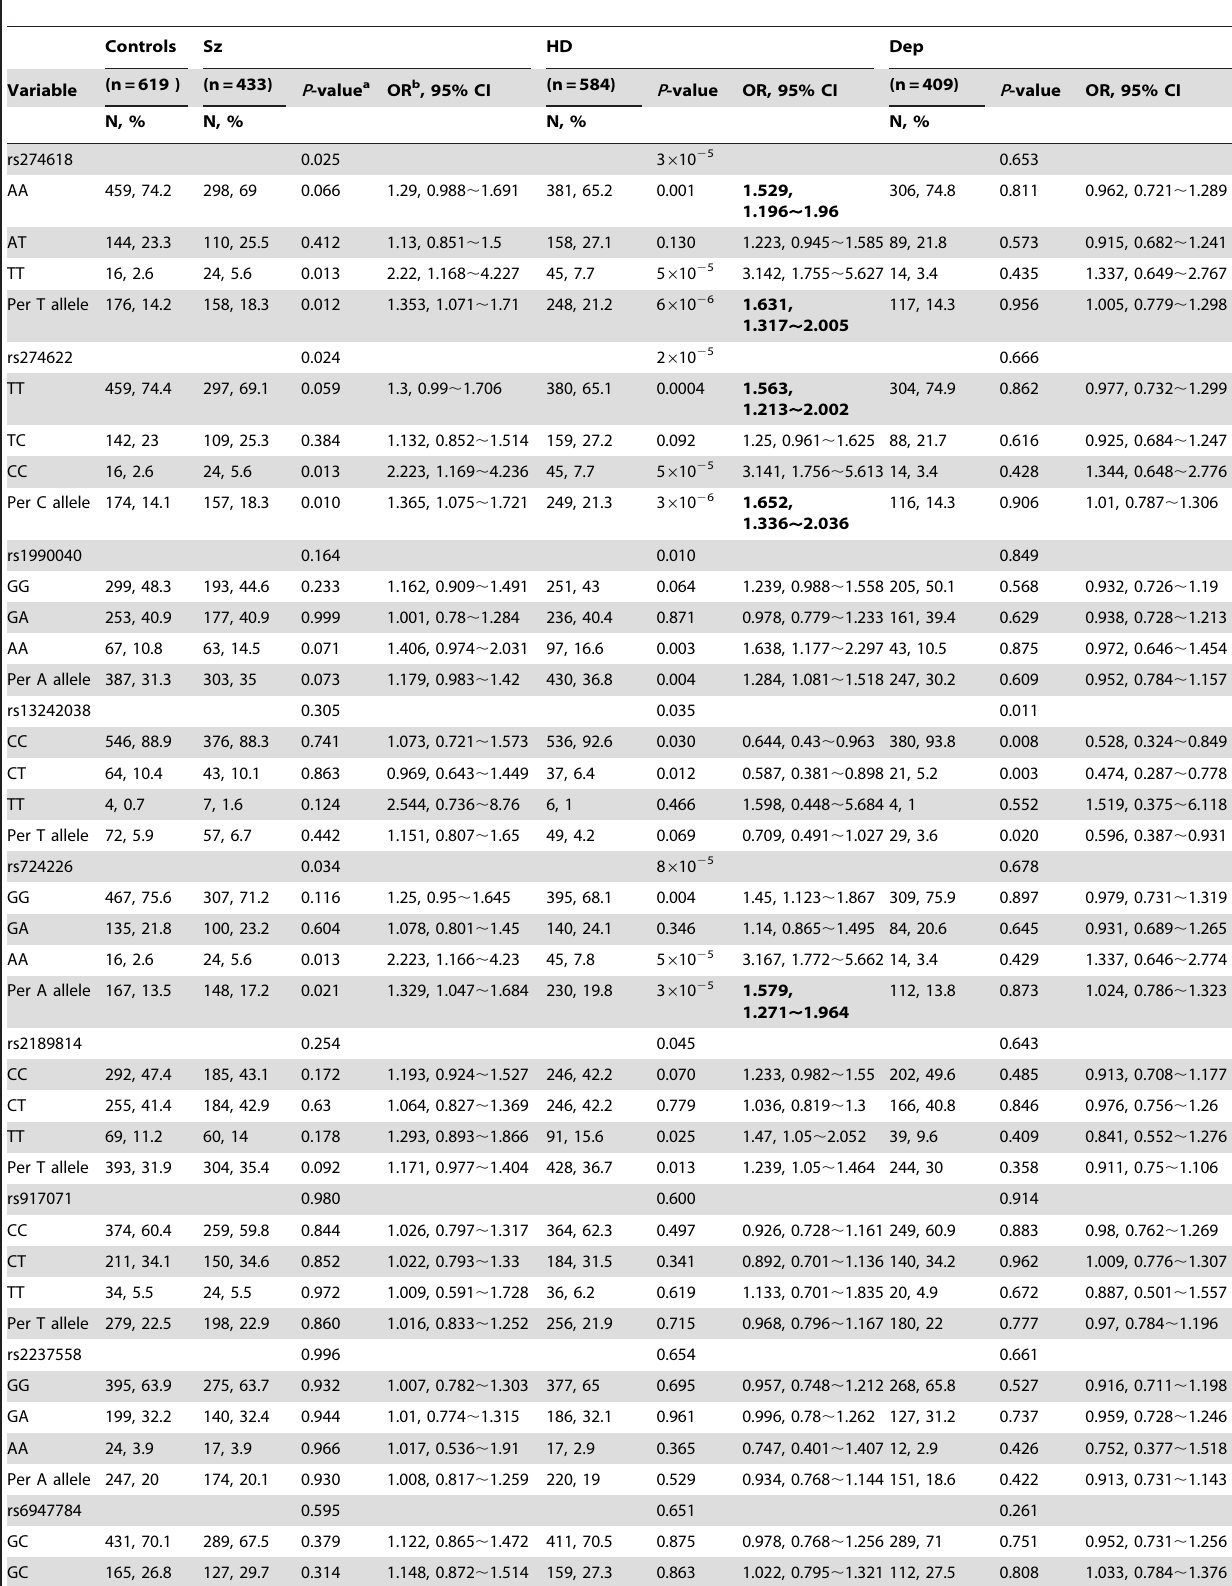
Table 1. Genotypic and allelic frequencies of GRM3 polymorphisms in the controls and patients with different diseases.